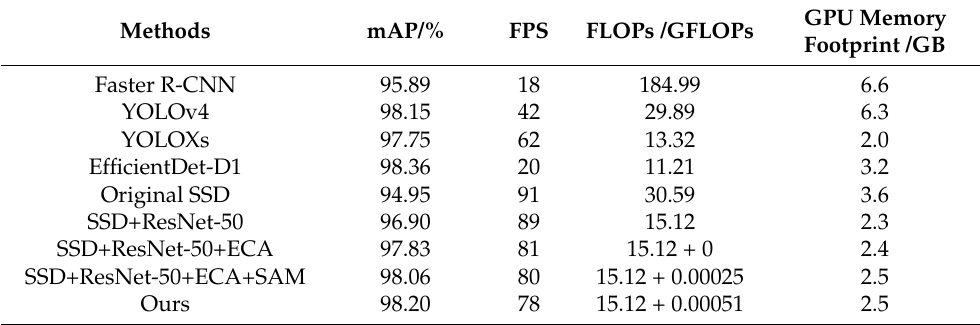
Table 4. Performance comparison of different models. (FLOPs and GPU memory footprint